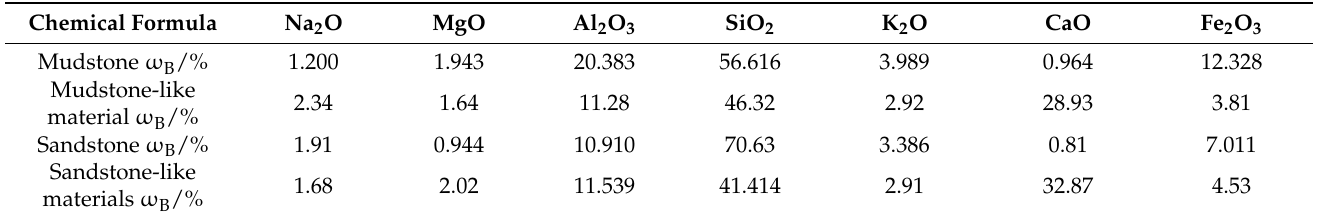
Table 1. Quantitative analysis of X-ray fluorescence spectroscopy (XRF) compositions of rocks and similar